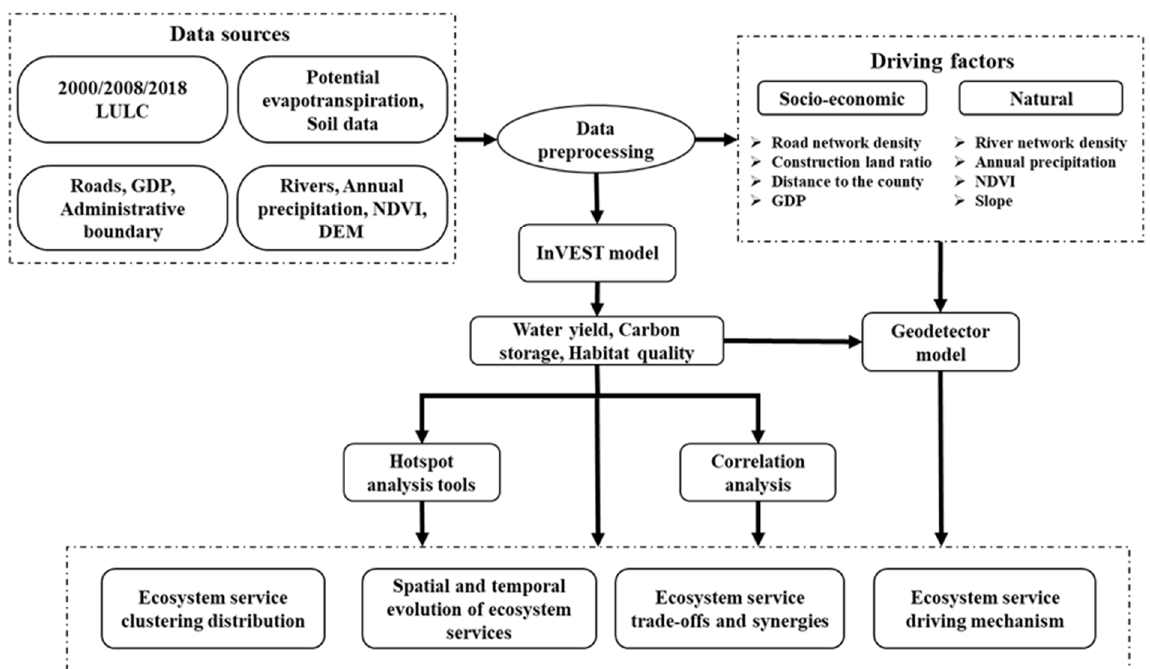
Figure 2. Flowchart of this study.